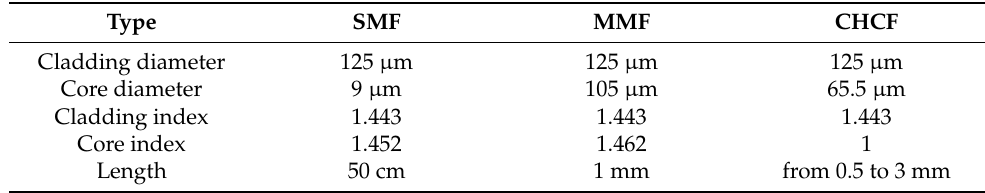
Table 2. Parameter of the optical fibers.